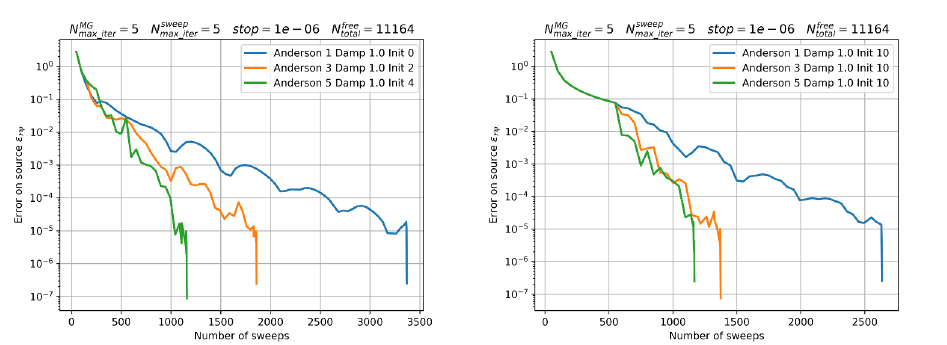
Figure 2: Effect of triggering the Anderson acceleration as soon the history length is enough to compute the correct Anderson order (left) or by imposing a fixed number of free iterations - here 10 - before starting the acceleration